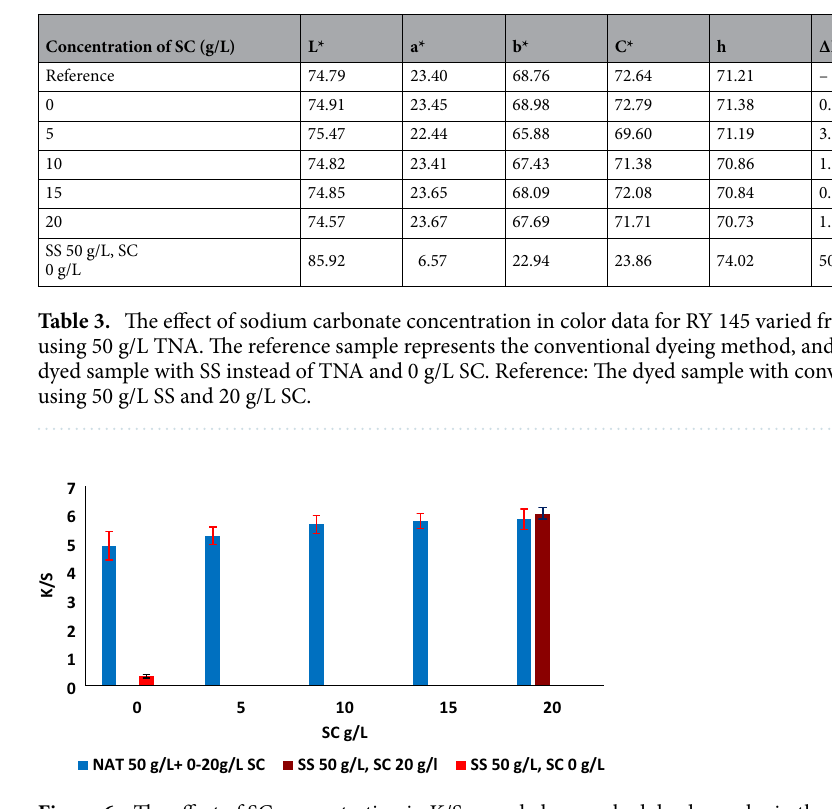
Figure 6. The effect of SC concentration in K/S recorded on washed dyed samples in the presence of TNA 50 g/L, 2% owf dye concentration, LR 1:40 at 70 °C, 60 min, compared with conventional dyeing using RY